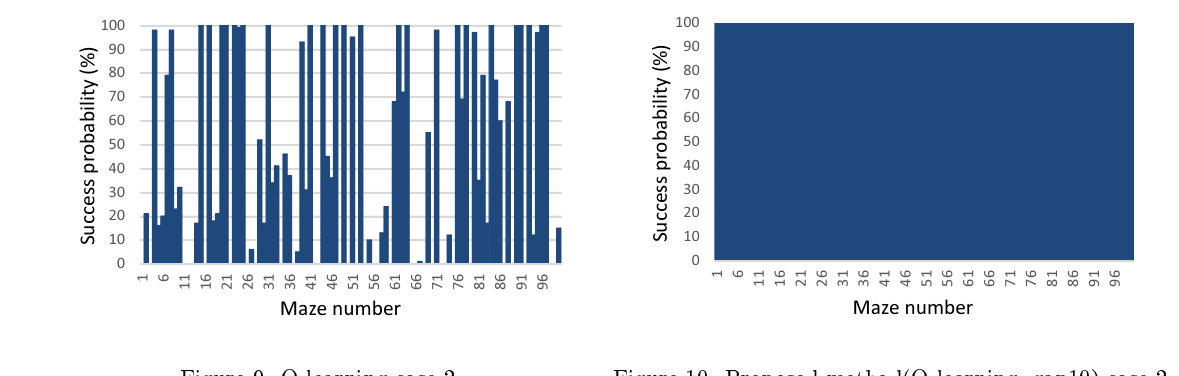
Figure 9: Q-learning case 2 Figure 10: Proposed method(Q-learning, gap10) case 2 Figure 11: Common Q-learning vs Proposed